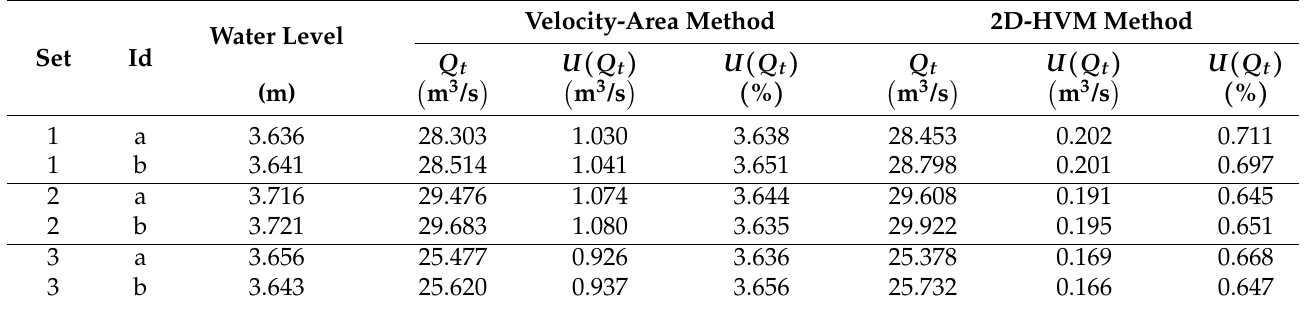
Table 4. Results for measurements of section GG7. Coverage coefficient— k =